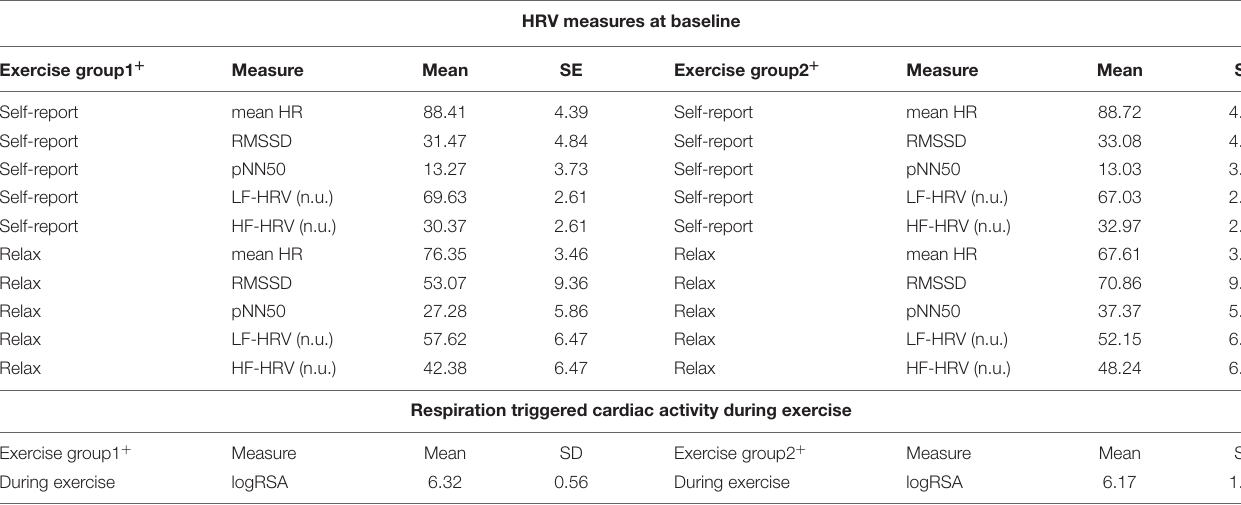
TABLE 1 | Changes in HRV measures during the two baseline recordings comprising the questionnaire period preceding the affective task 1, pre-exercise (10 min) and the 3 min relaxation period following the affective task and preceding the 30 min exercise session. HRV measures at baseline